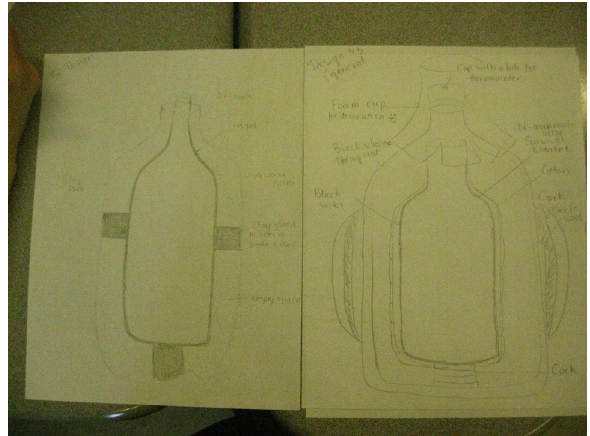
Figure 7. Comparison of two different designs.